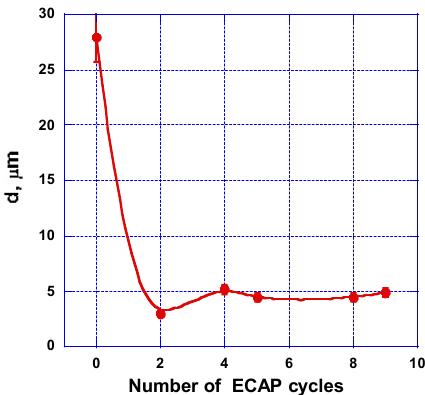
Figure 7. Impact of the number of ECAP passes on the grain size in a AZ31 billet as processed at 200